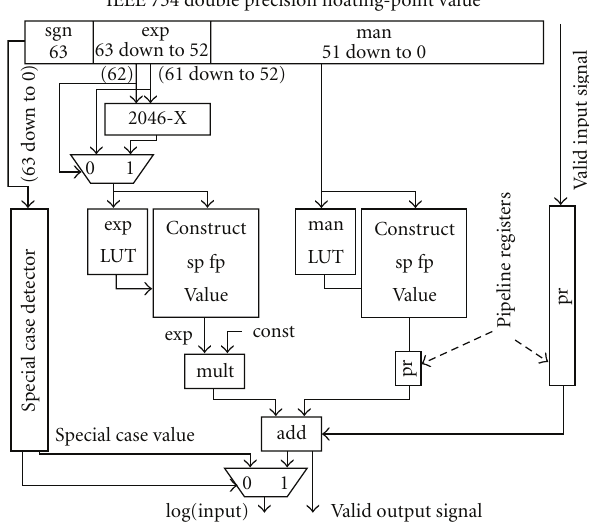
Figure 3: Block diagram of